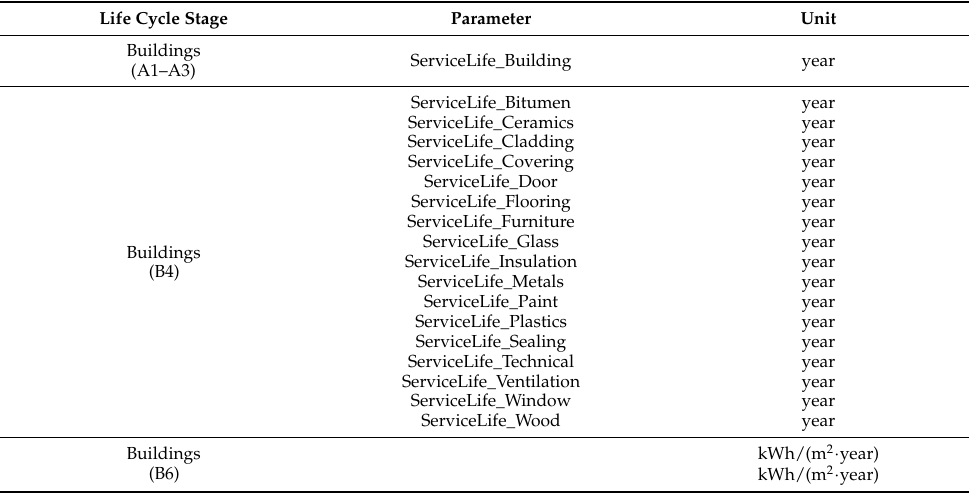
Table A1. List of parameters for the neighborhood sub-element